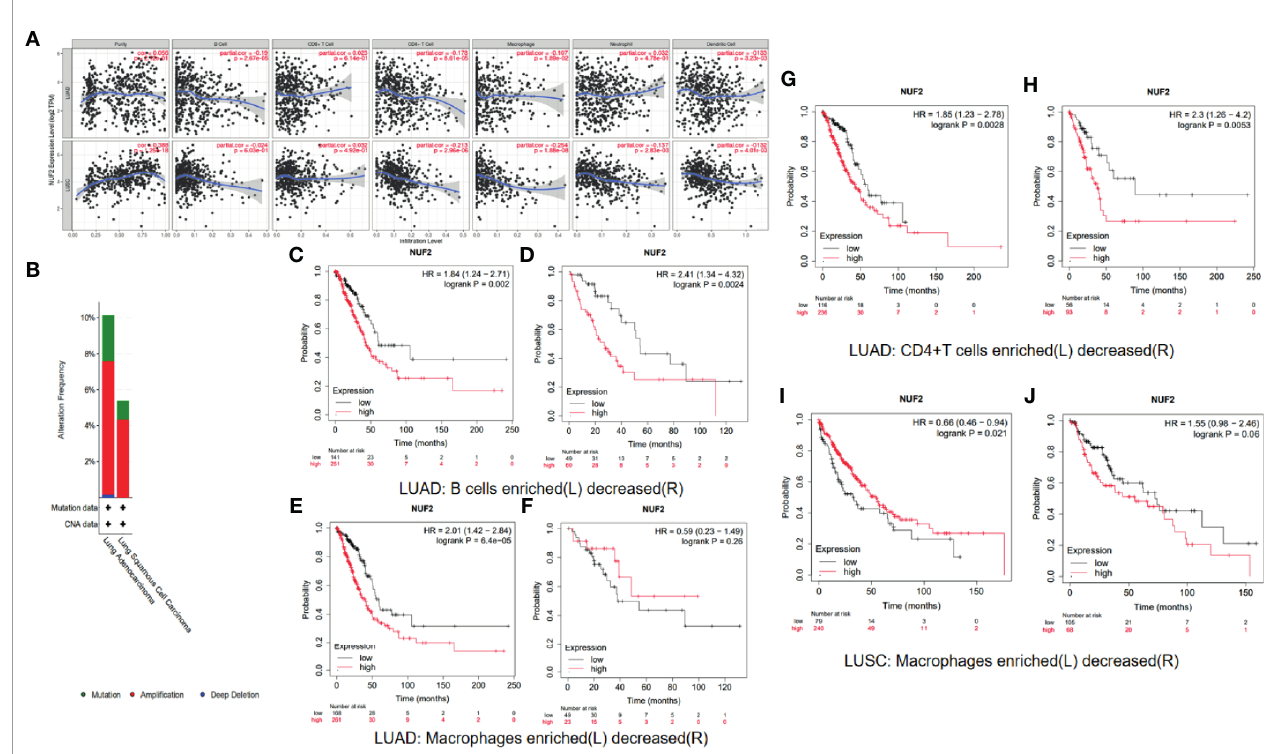
FIGURE 9 | (A) Immune correlation analysis of NUF2 based on immune in fi ltration. NUF2 expression were negatively correlated with B cell, CD4 + T cell, Macrophage and dendritic cell immune in fi ltration levels of LUAD and also negatively correlated with CD4 + T cell, Macrophage, Neutrophil and dendritic cell immune in fi ltration levels of LUSC. (B) Gene alterations in detailed subtypes of NSCLC. (C – J) Kaplan-Meier survival curve comparing the OS time for different NUF2 expression in NSCLC based on immune cells in fi ltration.